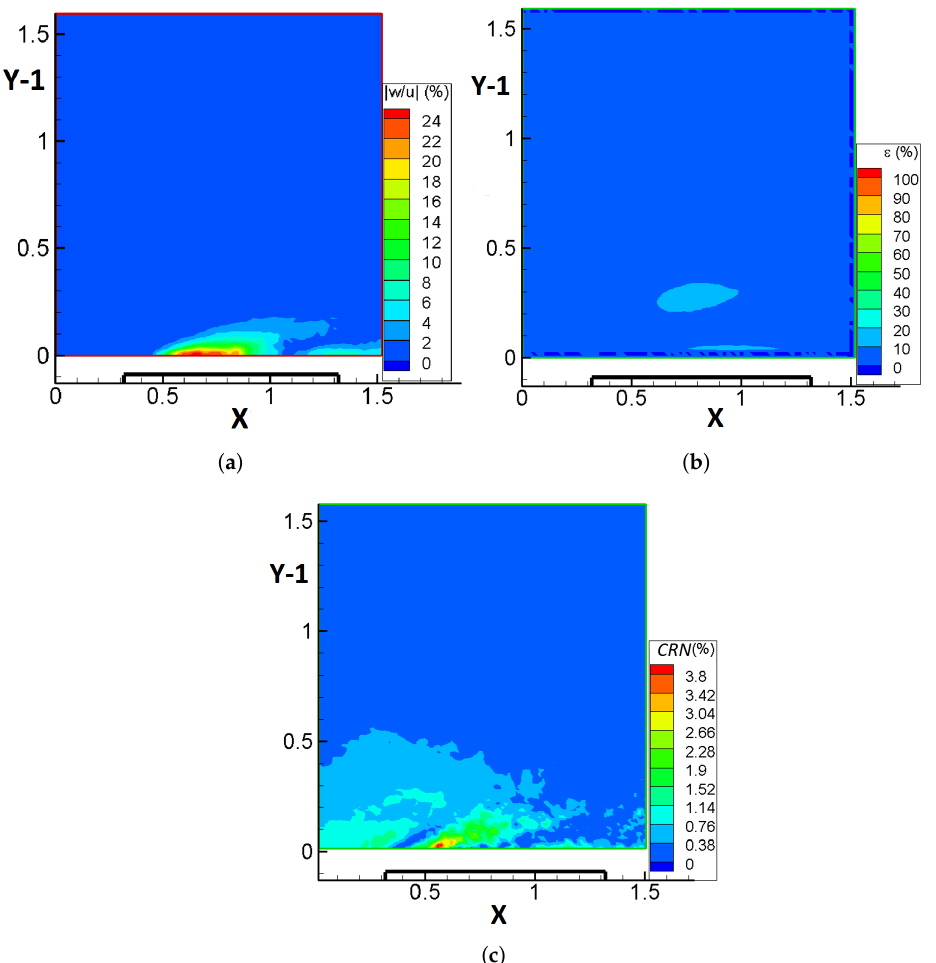
Figure 11. Contours of: ( a ) the absolute value of the fraction of the third velocity component w over the u velocity component (acquired through stereo-PIV), | w / u | %, on plane B, ( b ) the difference between the CFD estimate of the total velocity and that of the PIV method, (cid:101) ( % ) , on plane B, and ( c ) the non-dimensional continuity residual, CRN ( % ) , for the PIV results on plane B. The solid boundary of the cube is denoted by the thick black line, while X and Y are non-dimensional coordinates (non-dimensional distance of 1 corresponds to 1 cube height). Flow is from left to